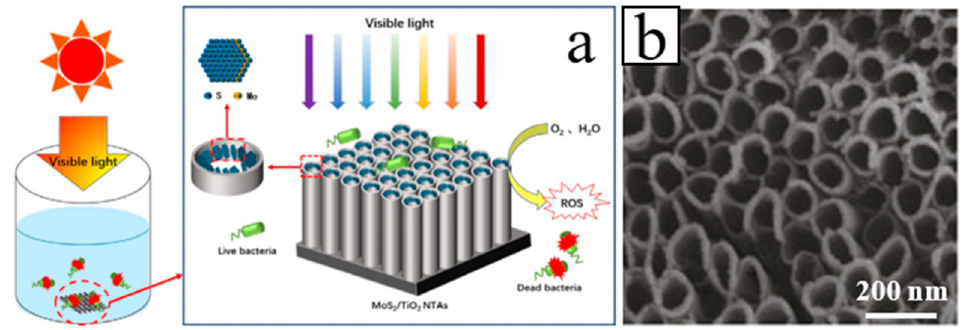
Figure 2. ( a ) Schematic diagram and ( b ) SEM image of the MoS 2 /TiO 2 NTs fabrication process [55].